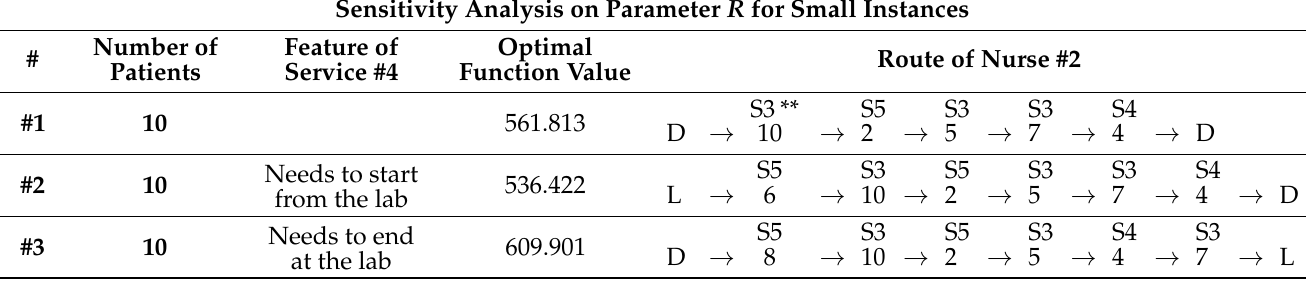
Table 8. Sensitivity analysis on parameter R for small instances.